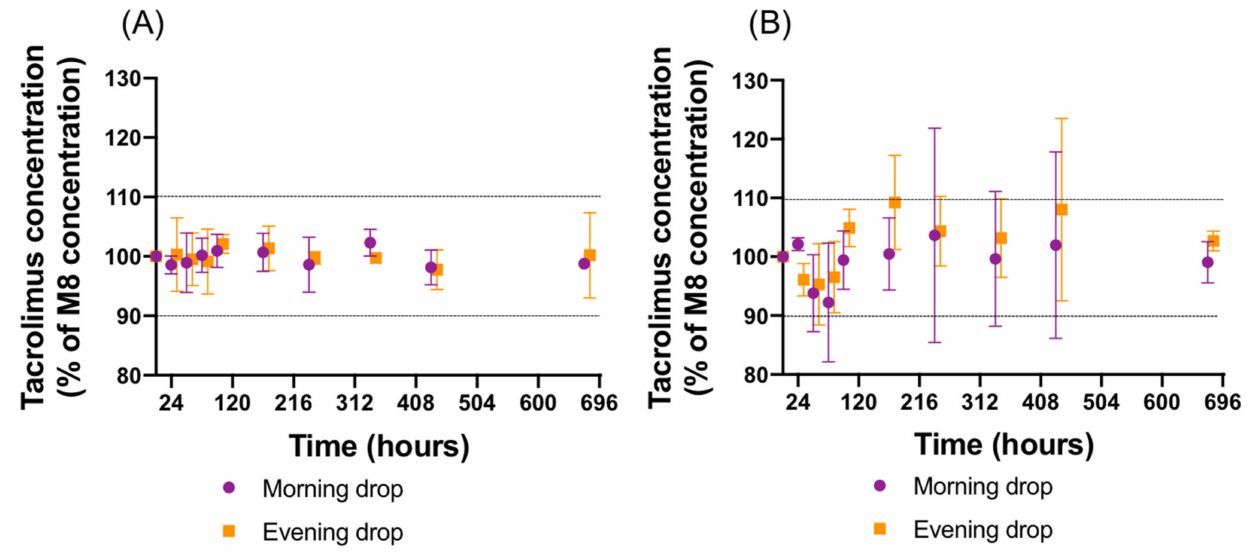
Figure 6. Evolution of the mean concentration ( ± IC 95%) in opened eyedroppers during one month of storage at 5 ◦ C after eight months of storage at 5 ◦ C with ( A ) 1 mg/mL tacrolimus formulation and ( B ) 0.2 mg/mL tacrolimus